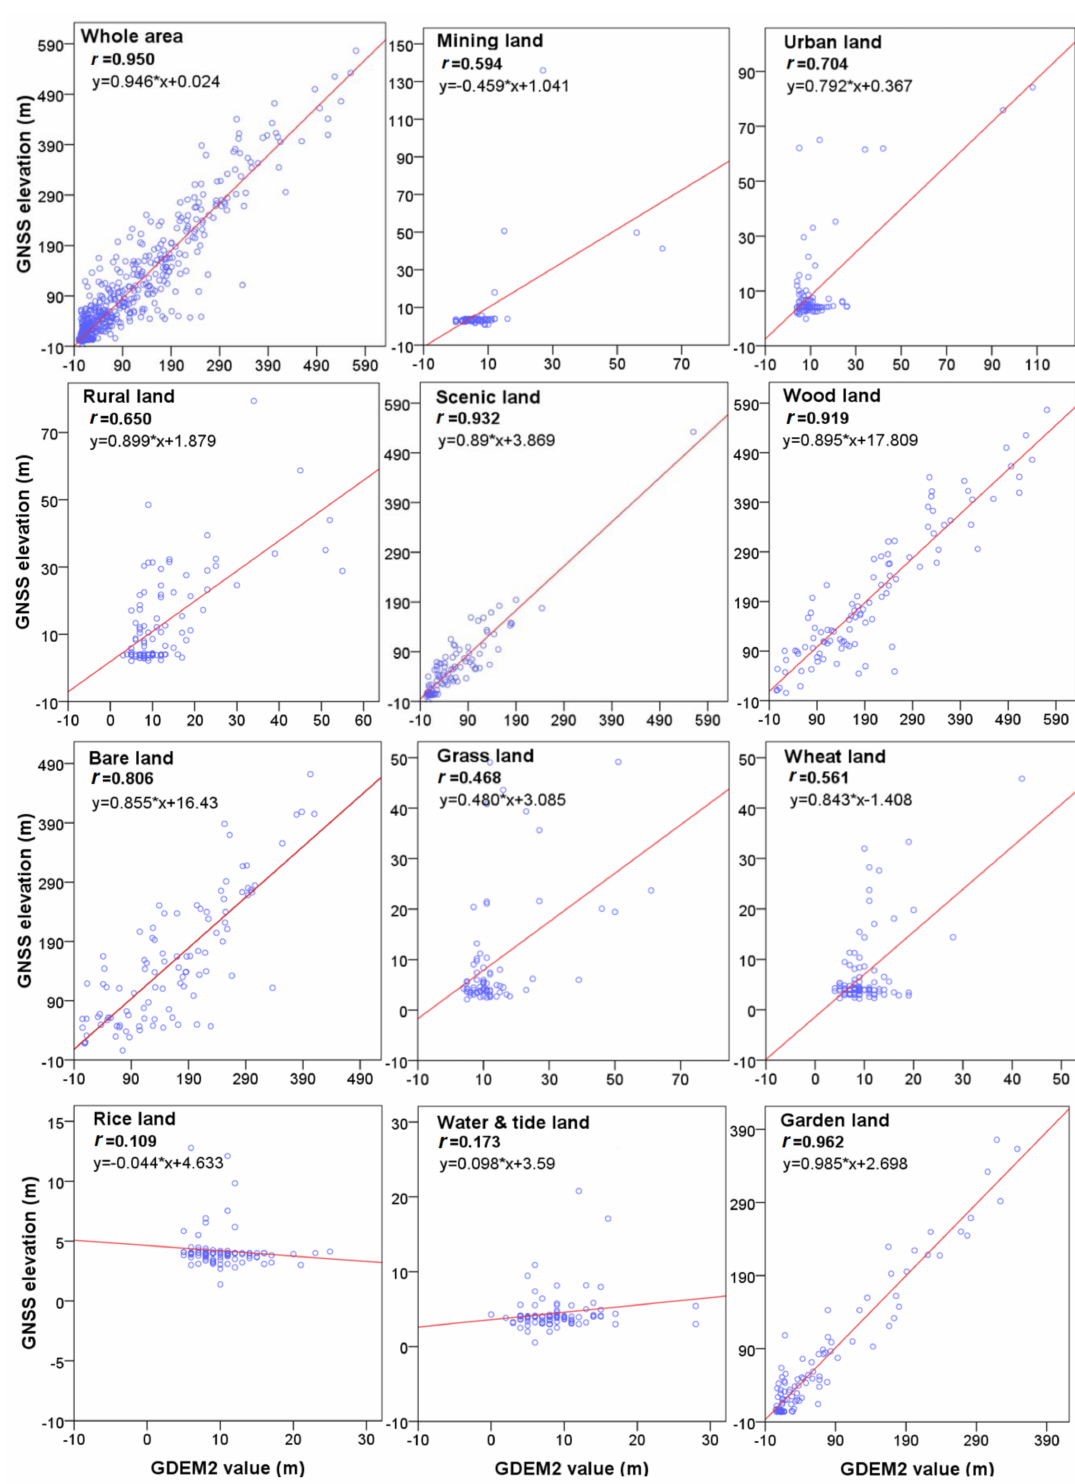
Figure 4. Scatterplots of the original ASTER GDEM2 against the calibration data (that is, the first sample set). Land-use specific simple linear regression models (where the asterisk symbol indicates multiplication) and correlation coefficients are shown in each